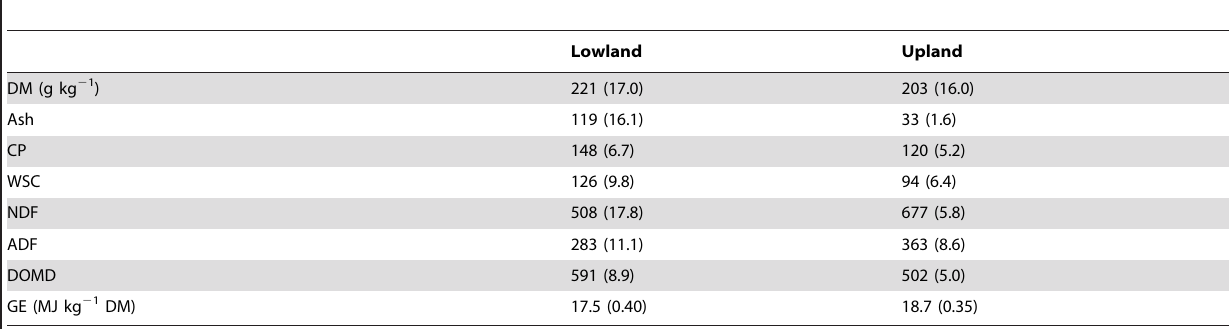
Values are means (with standard errors) of eight weekly samplings across the measurement period at each site. All values g kg 2 1 DM unless otherwise stated. doi:10.1371/journal.pone.0107861.t002 PLOS ONE |